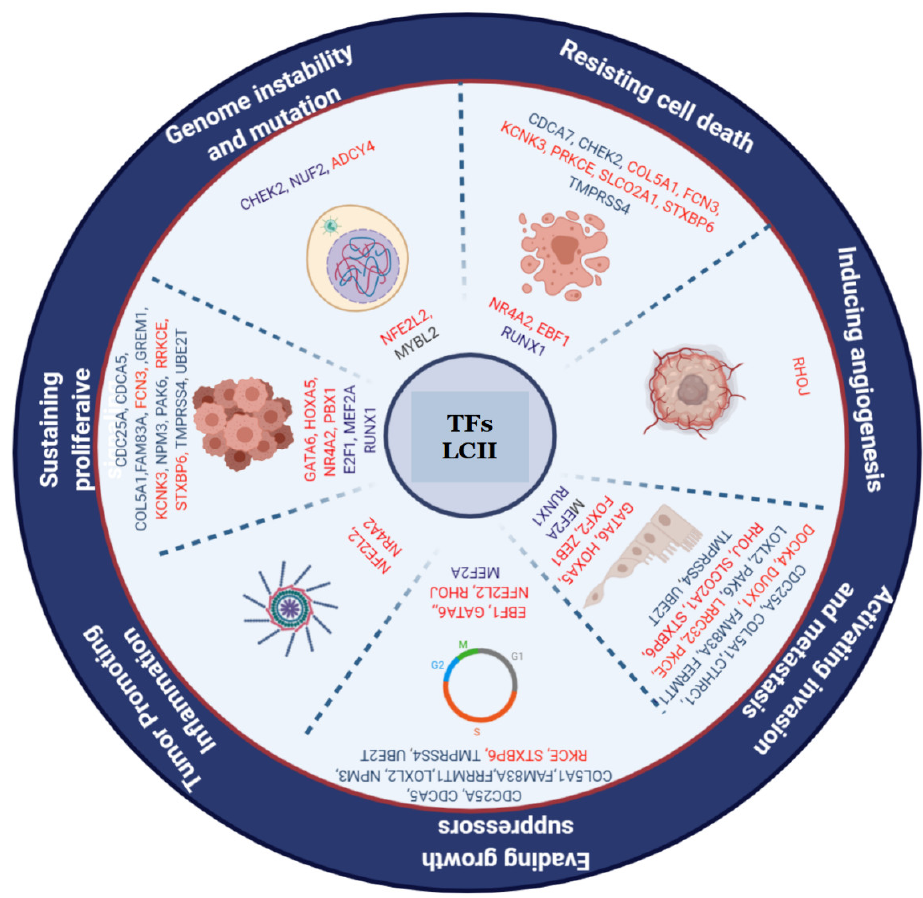
Figure 10. Hallmarks of cancer related to the genes of the LCII coexpression network. The TF is in the center of the circle, and the DEGs are more external in the circle. All overregulated genes are in blue, and all downregulated genes are in red.